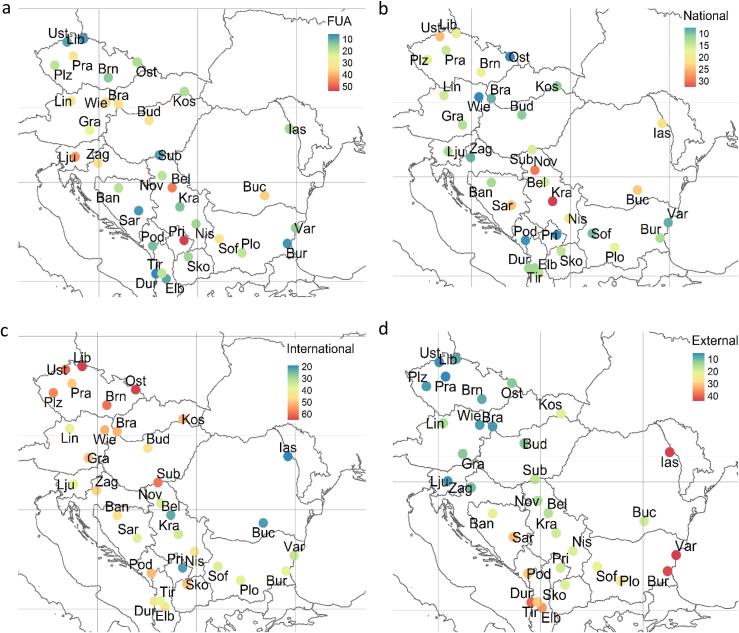
Percentage impact of geographical areas to the 33 studied cities estimated with SHERPA. FUA: functional urban area, national, international (within the model domain) and external (areas beyond the domain and sources not considered in this simulation e.g. international maritime). The values are provided in numeric format in Tables S2 and S3.